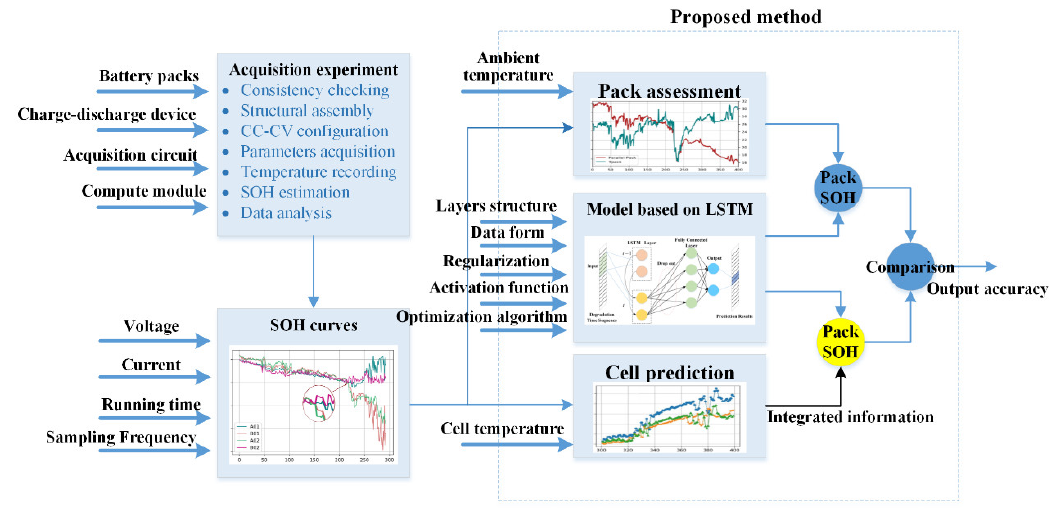
Figure 4. Schematic overview of the whole paper.